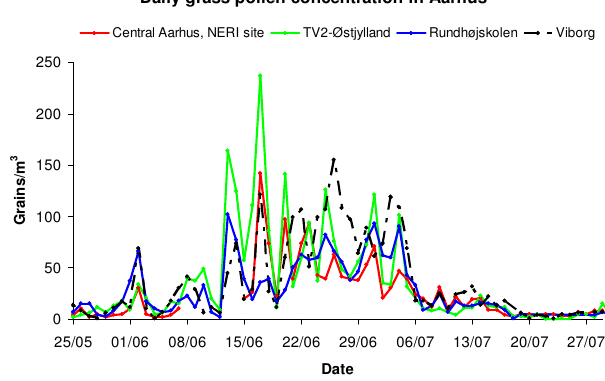
Fig. 5. Daily grass pollen concentrations at the three monitoring sites in Aarhus and the operational pollen trap in